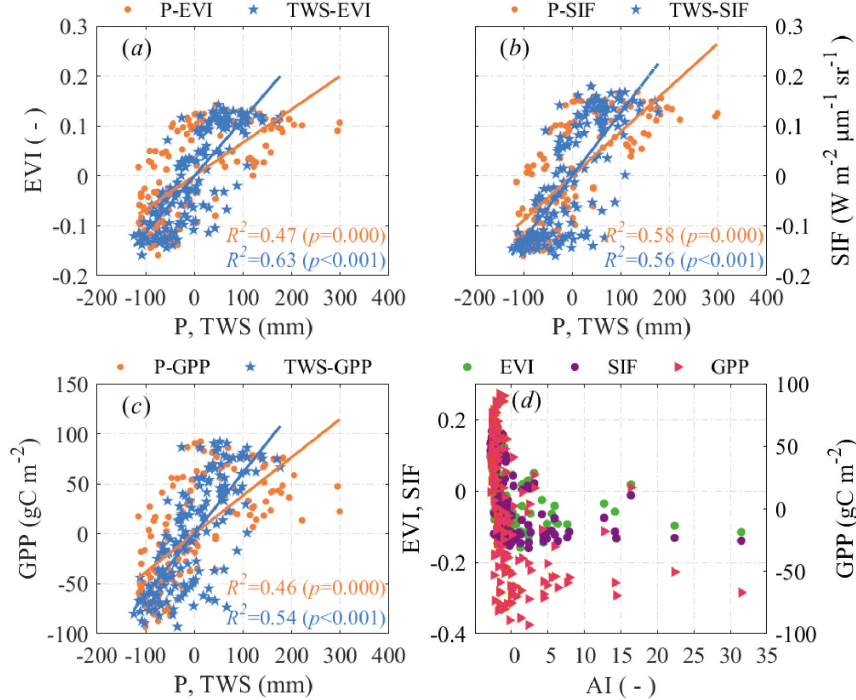
Figure 7. Scatterplot of monthly anomalies of precipitation ( P ), total water storage (TWS), aridity index (AI), enhanced vegetation in- dex (EVI), solar-induced chlorophyll fluorescence (SIF), and gross primary production (GPP) over the entire basin. Each point represents a basin-wide averaged monthly data.